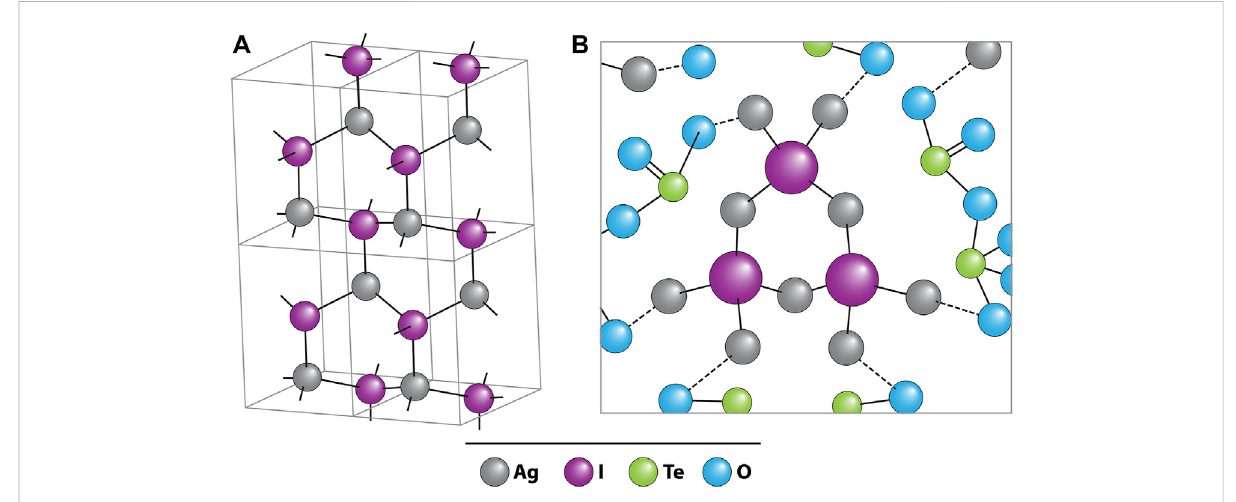
FIGURE 4 Schematic drawings of (A) β -AgI crystal in wurtzite structure; black balls: Ag + , open balls: I − . (B) Three [Ag 4 I] units sharing bridging Ag + ions in silver tellurite glass; gray circles: O 2 − (Lee et al.,